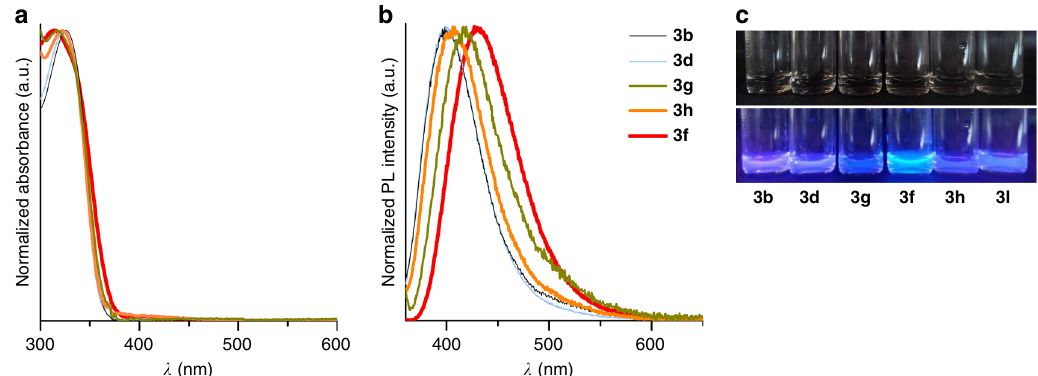
Fig. 6 Basic optical properties of the DHPIQs. a UV – vis absorption spectra of DHPIQ solution in MeCN (ca. 10 − 4 M). b Fluorescence spectra of DHPIQ solution in MeCN (ca. 10 − 4 M) were obtained upon sample excitation with 350 nm. c Appearance of DHPIQ solutions under ambient light and under UV